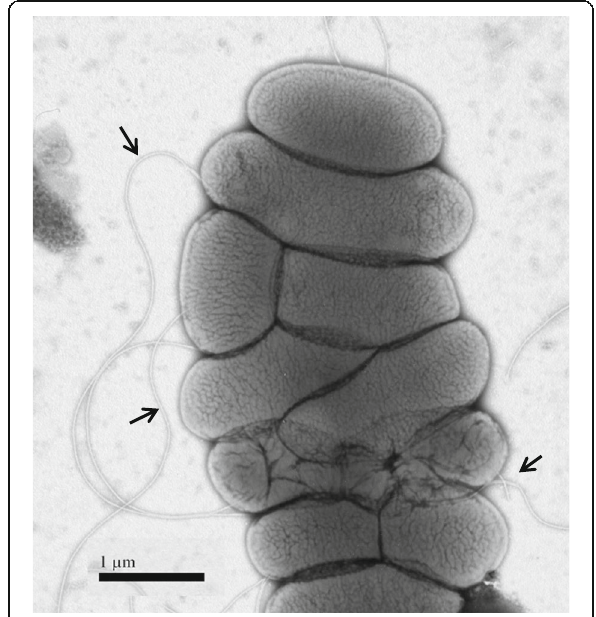
Fig. 1 Transmission electron photomicrograph of a typical Cronobacter sakazakii strain (ES632) grown on Trypticase soy agar supplemented with 1% sodium chloride, and incubated at 37°C for 22h. The cells were negatively stained with 0.5% sodium phosphotungstate (pH6.8). Note the presence of numerous peritrichously expressed flagella (arrow). Bar represents 1 μ